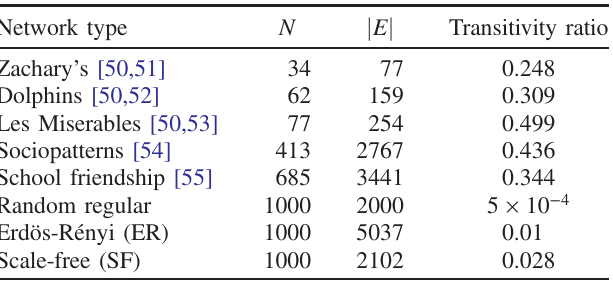
TABLE I. Summary of the main characteristics of the networks considered for the comparison between different optimization methods: number of nodes N , number of undirected edges j E j , and the transitivity ratio, defined as the average ratio between the actual number of closed triplets and the number of connected triplets of nodes. More details on the structure of the networks are provided in the